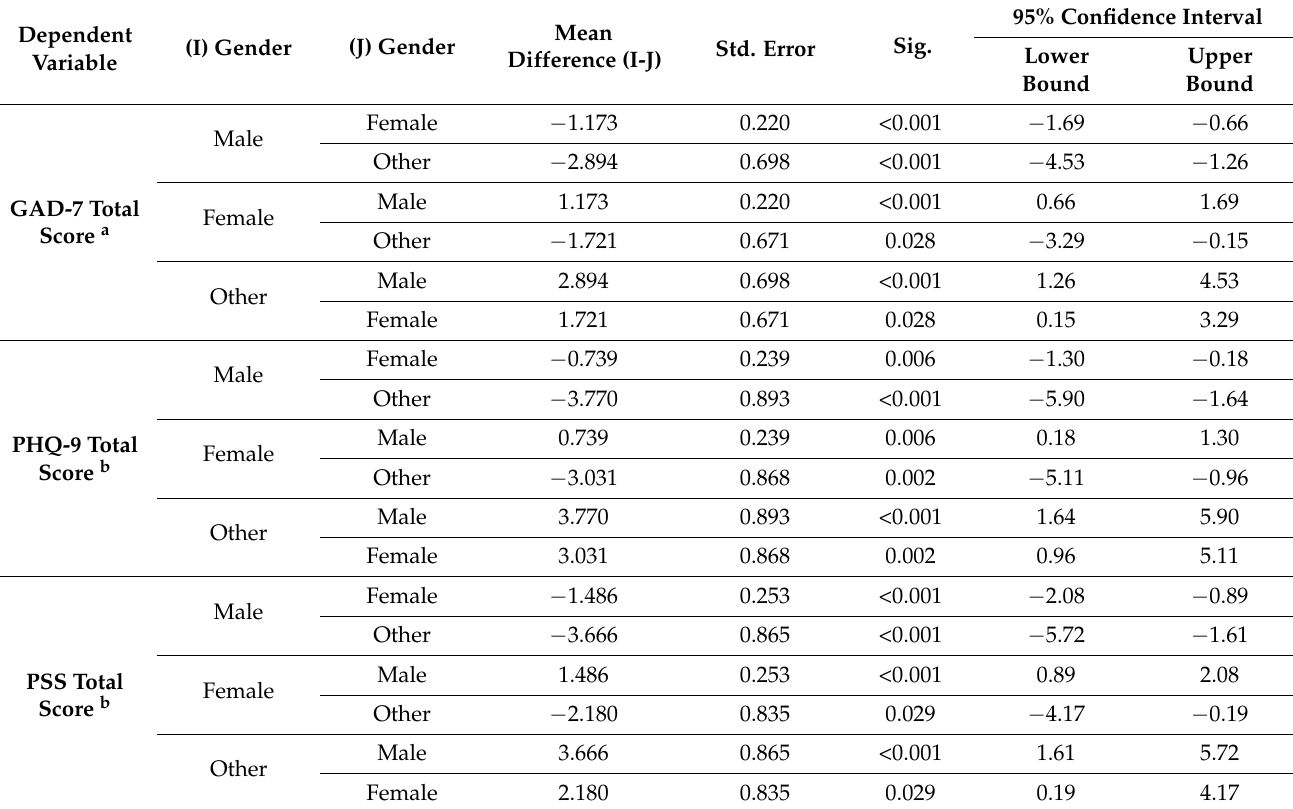
Table 5. Tukey HSD and Games–Howell post hoc multiple